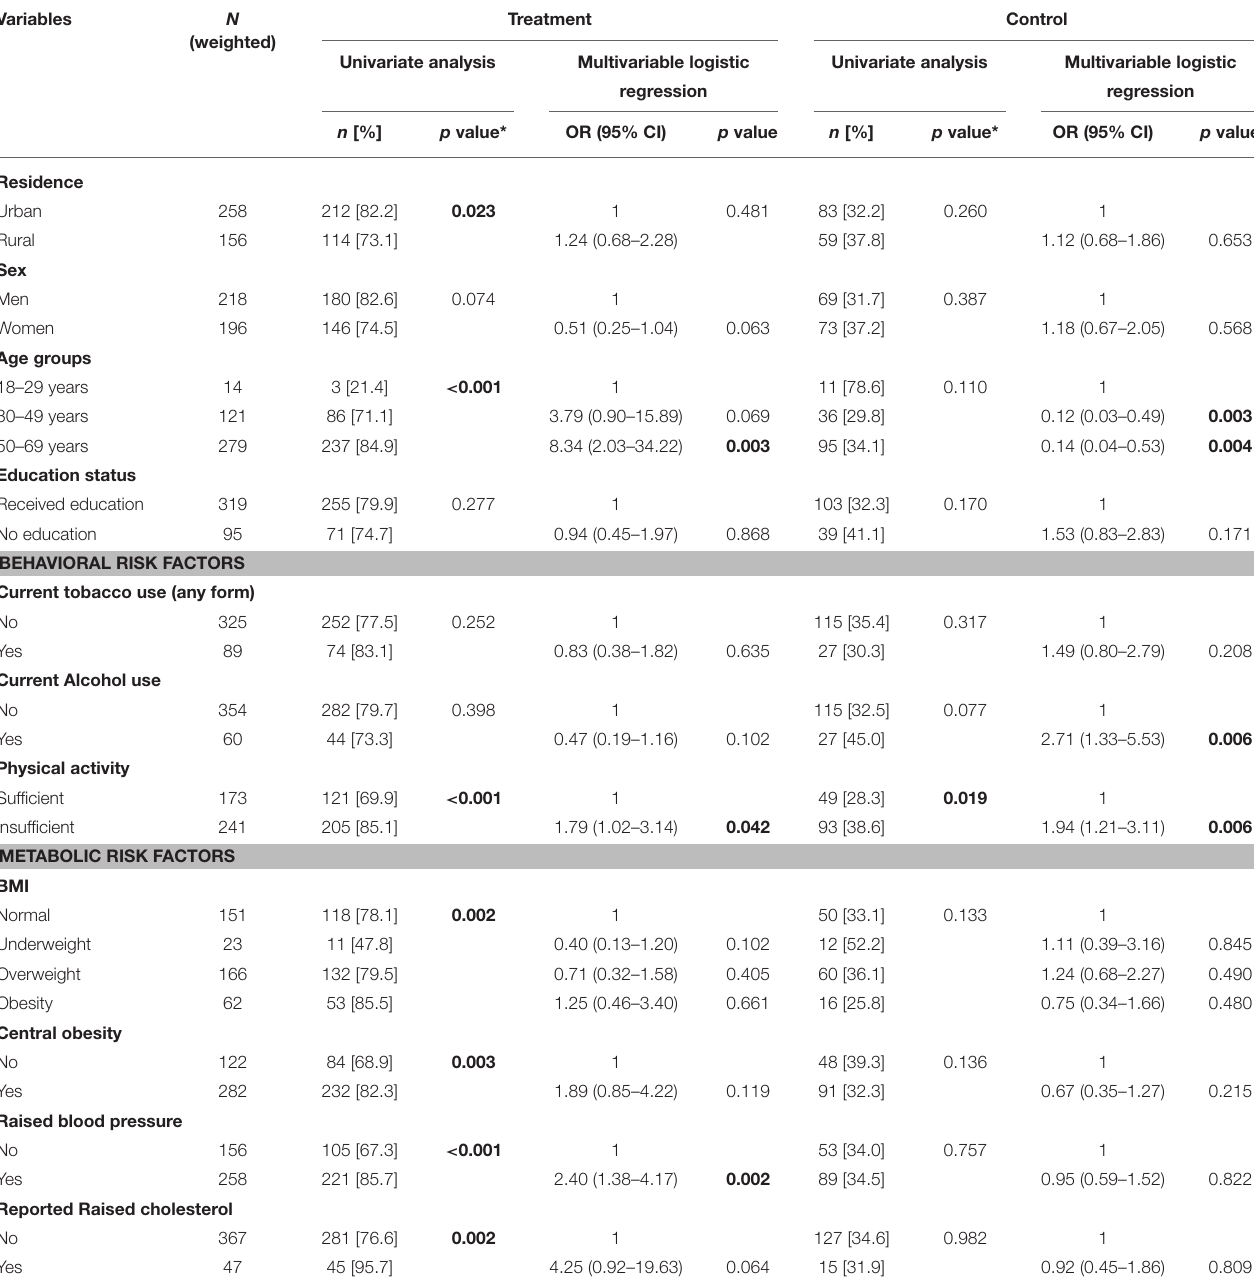
TABLE 3 | Determinants (adjusted OR) of treatment and control of diabetes among adults aware of diabetes aged 18–69 years in India. Variables N Treatment Control (weighted) Univariate analysis Multivariable logistic Univariate analysis Multivariable logistic regression